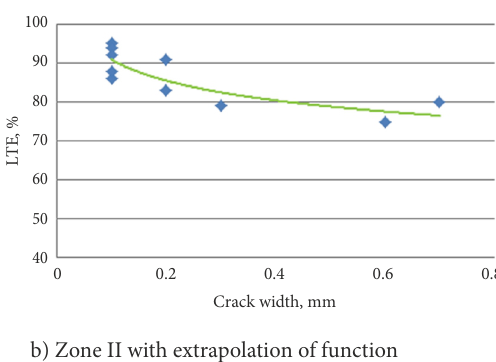
b) Zone II with extrapolation of function LTE-crack width of